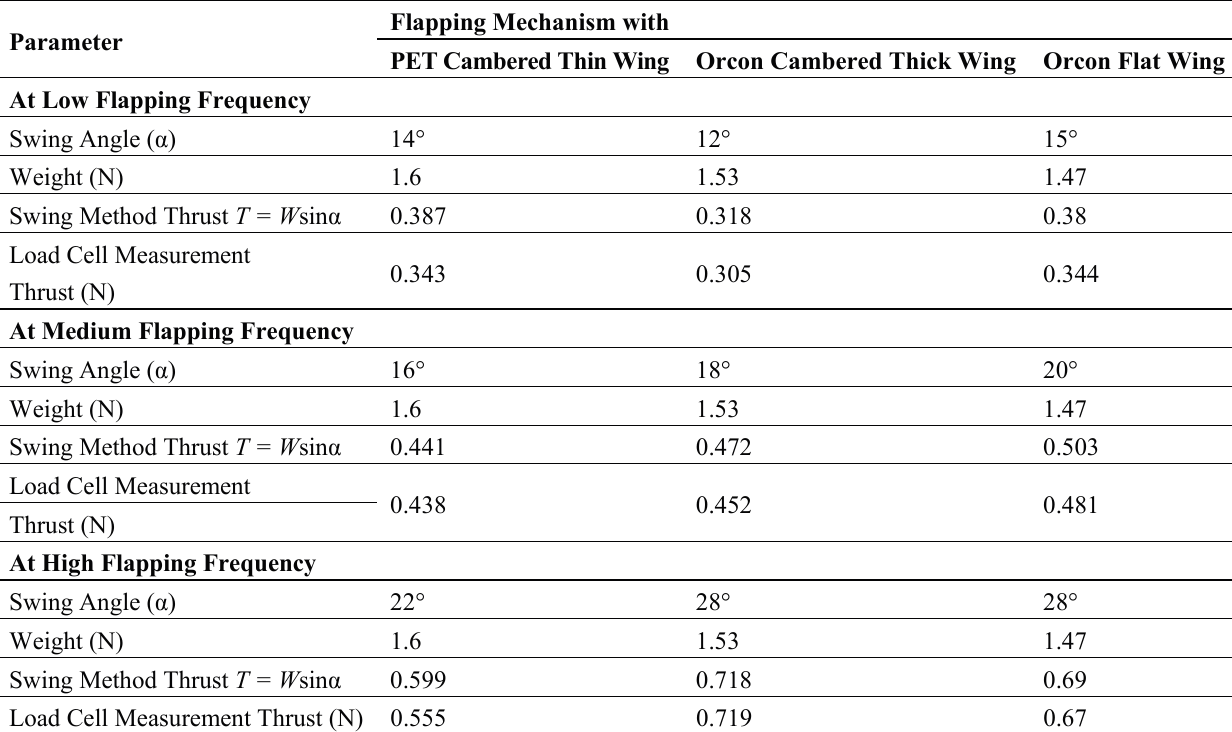
Table 2. Comparison of thrust between load cell and swing